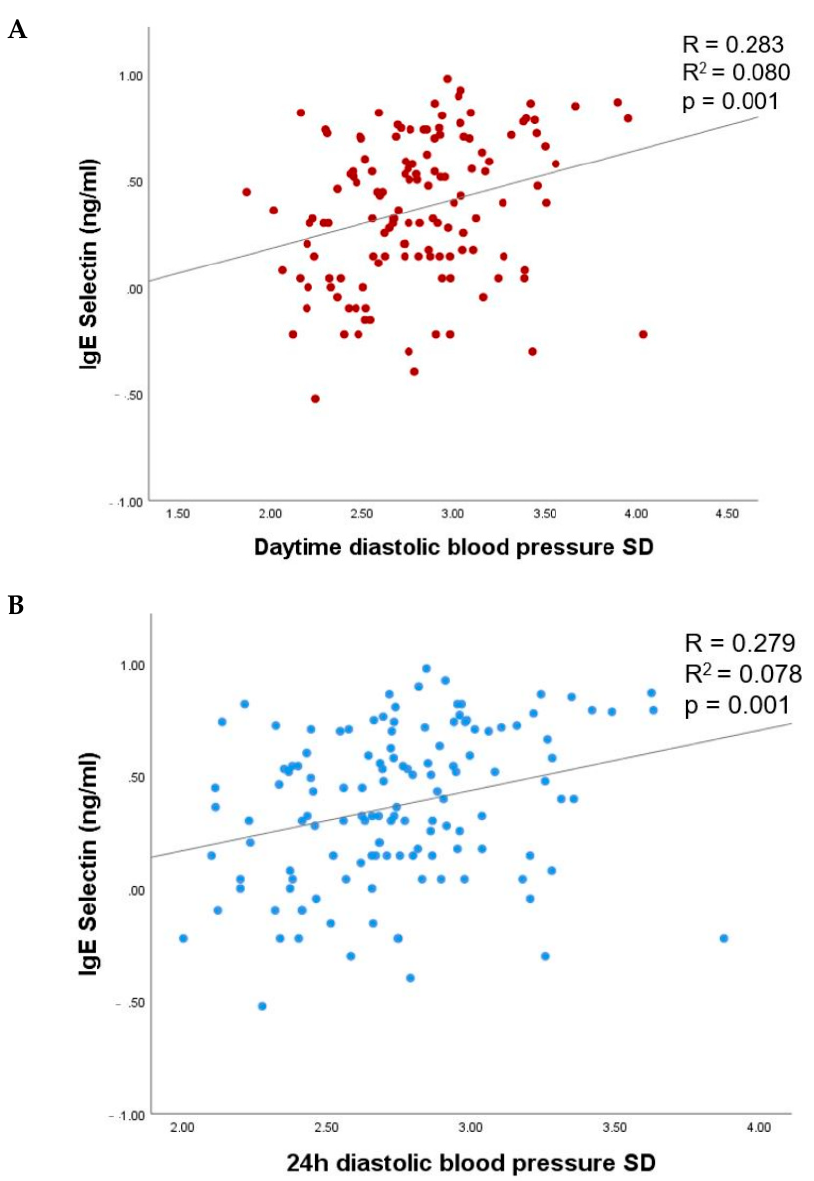
Figure 2. The relationship of lgE-selectin with daytime ( A ) and 24 h ( B ) BP variability. SD, standard deviation.